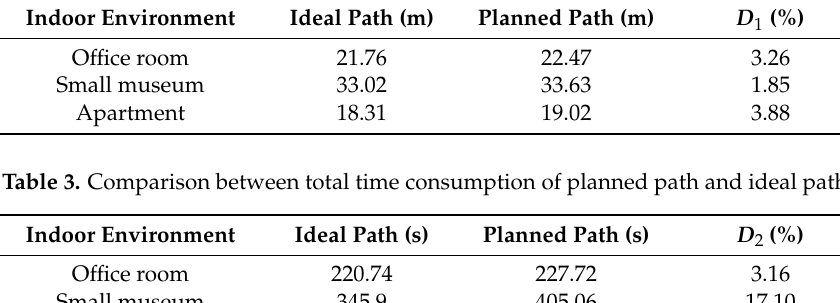
Figure 16. Planned and ideal path in small museum. Table 2. Comparison between path length of planned path and ideal path.